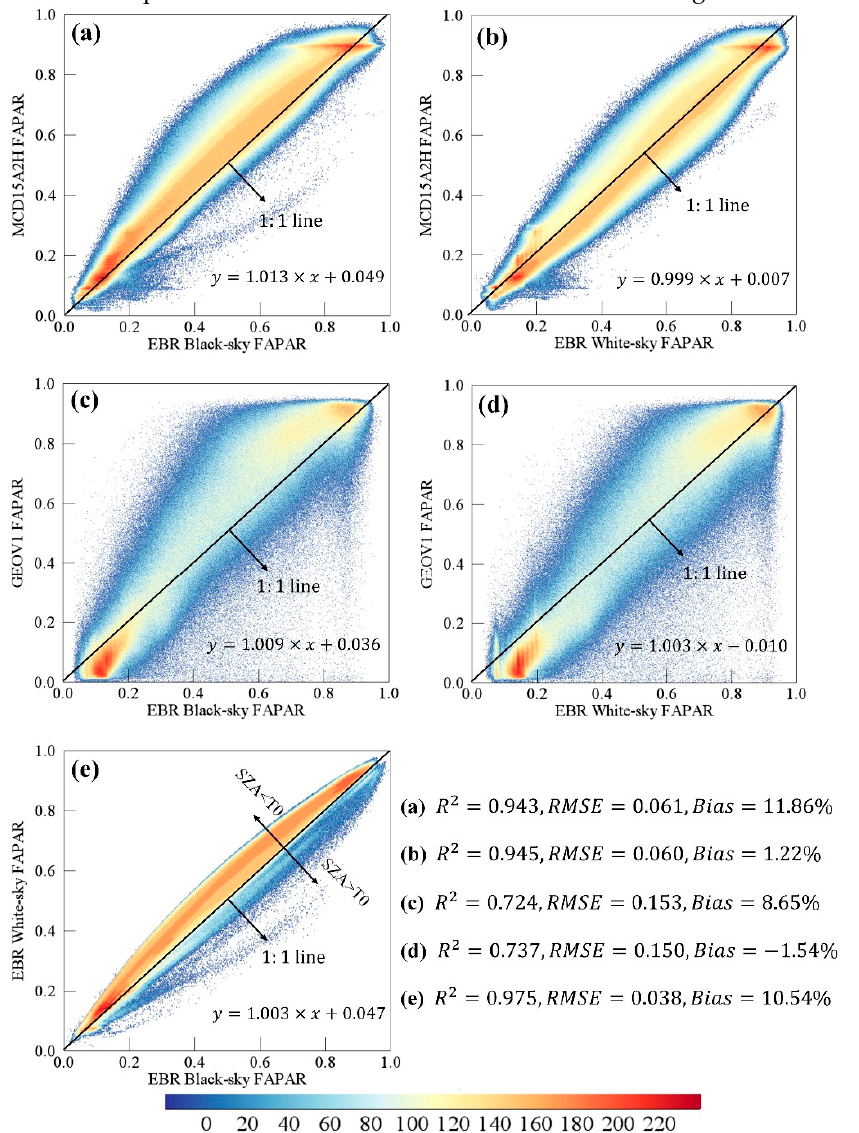
Figure 12. Comparison of FAPAR estimates for July 2005: ( a – b ) EBR black-sky and white-sky FAPARs against MOD15A2H FAPAR; ( c – d ) EBR black-sky and white-sky FAPARs against GEOV1 FAPAR; and ( e ) EBR black-sky FAPAR against EBR white-sky FAPAR (Note that the Sun Zenith Angle (SZA) threshold value (T0) was approximately